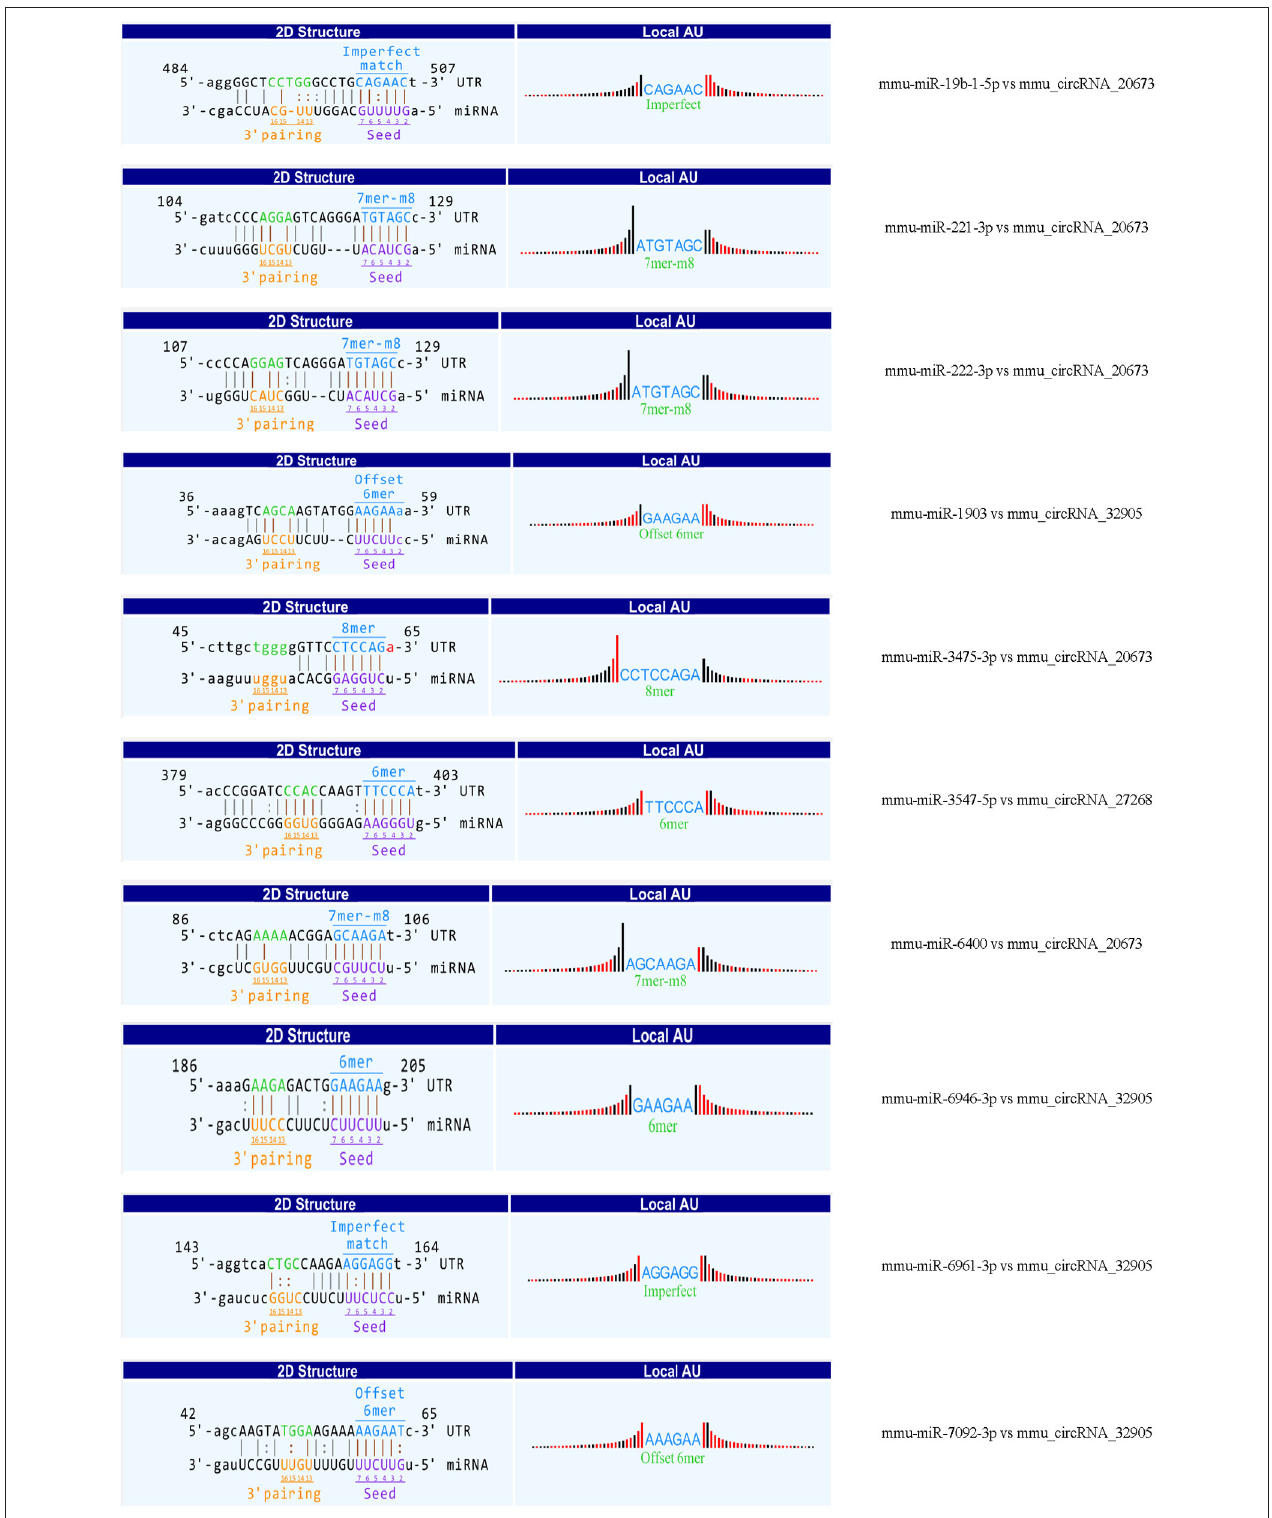
FIGURE 7 | The predicted binding sites between three verified differentially m 6 A-modified circRNAs and ten miRNAs.